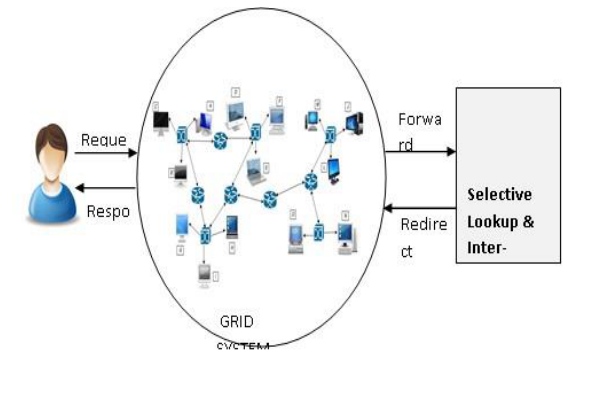
Figure 4. Architecture of selective lookup and interconnection of